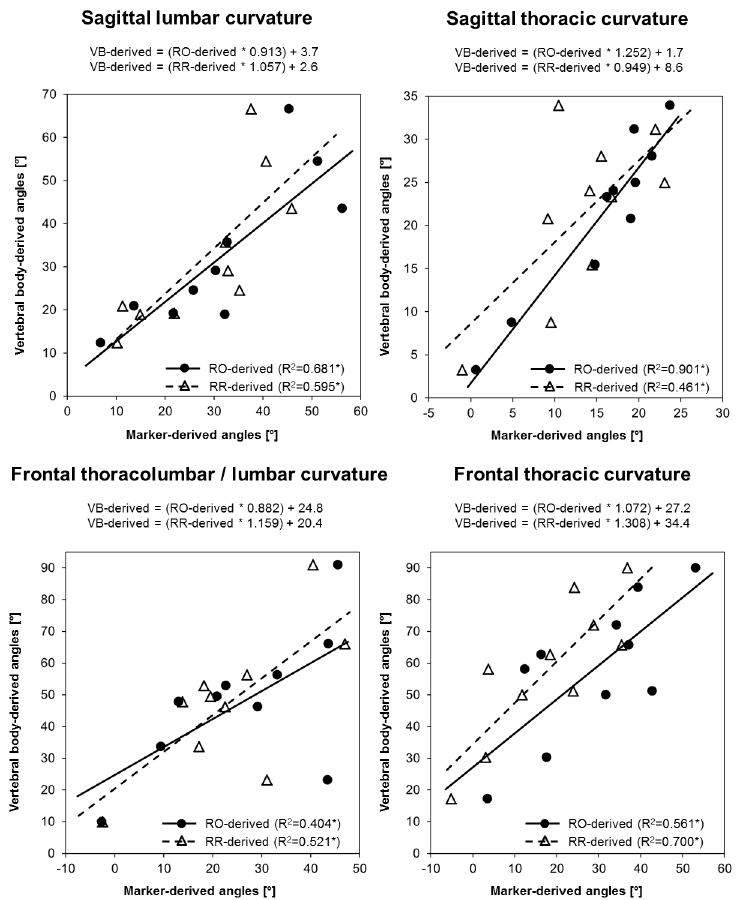
Fig 2. Scatterplots and regression equations illustrating curvature angle estimation accuracy. VB: vertebral body-derived curvature angles; RO: radio-opaque marker-derived curvature angles; RR: retro- reflective marker-derived curvature angles. The asterisks ( * ) indicate statistical significance at the level p (cid:1) 0.05.